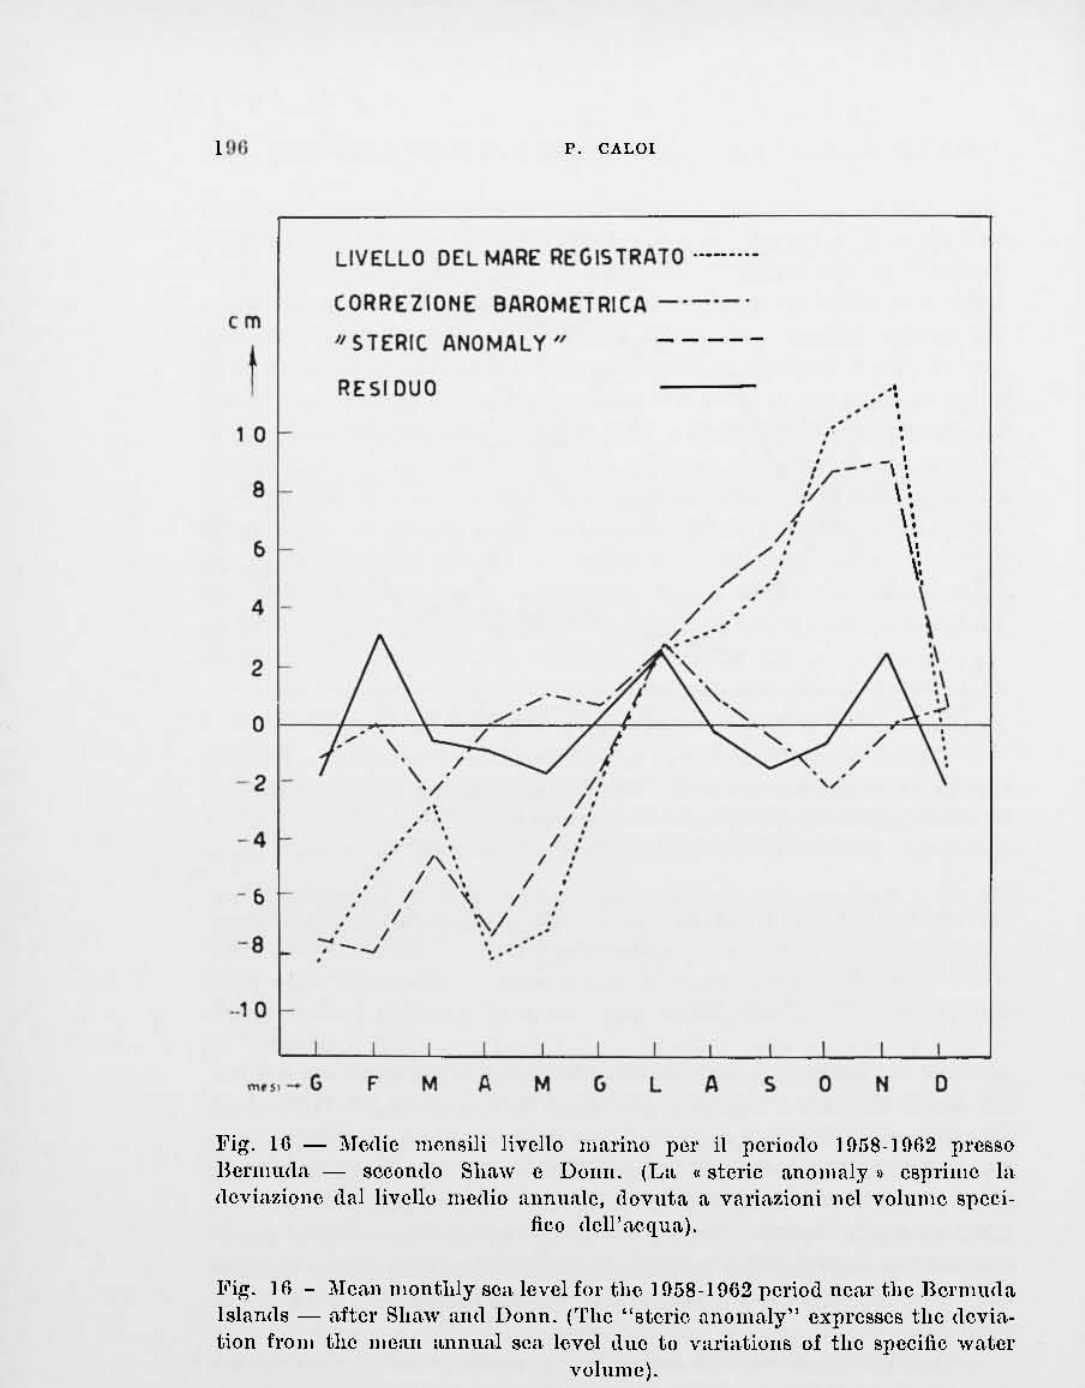
fico (ldl'M'qua). Fig. l r. - :!IIcan ll10nthly sea lcvc1 fol' tllC 1058-1062 pCl'iod nea!" tllC BCl'nnHIa lslall(\s - after Slww ami Donn. (Thc "stcrie nnolJwly" cxprcsscs thc devia tion frOlli thc menu annual sea level tluo tu variatioIlS oI thc spccilìc water